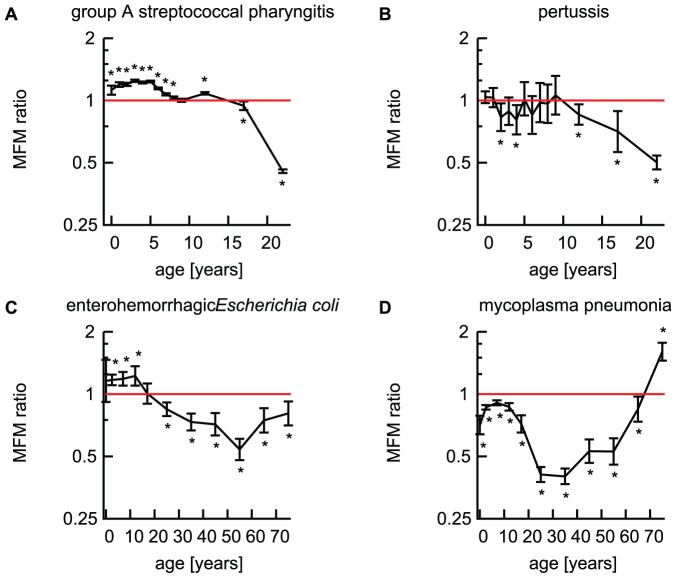
MFM ratios of bacterial infections; group A streptococcal pharyngitis (A), pertussis (B), enterohemorrhagic Escherichia coli (C) and mycoplasma pneumonia (D) reported from the sentinel points in Japan.95% confidence intervals for MFM ratios are indicated by error bars. Horizontal red solid lines indicate MFM ratio of 1. *: Significant with the Bonferroni's correction (p<0.05/13 in A and B; p<0·05/11 in C and D) [26].